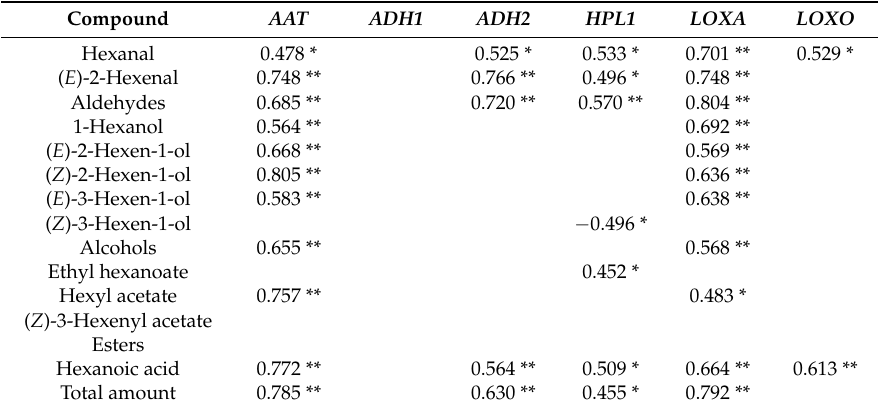
Table 2. Pearson’s correlation between C6 volatile compounds and expression of LOX-HPL genes in seven table grape